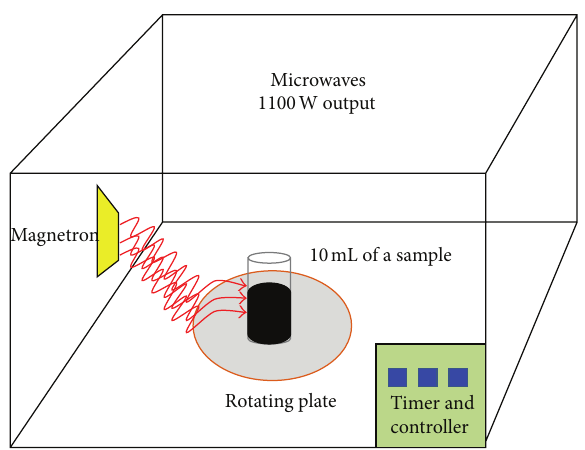
Figure 3: Illustration of experimental setup: the microwaves with 1100W output power was provided with a rotating plate, so that the radiation circumference covered an entire sample under